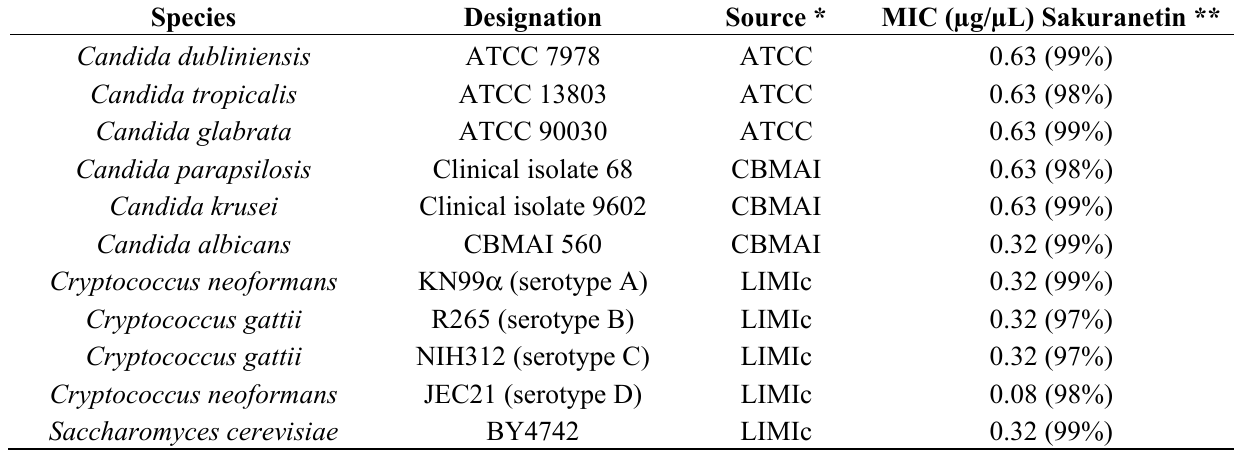
Table 4. Target strains used for antifungal activity assays and MIC results to sakuranetin.